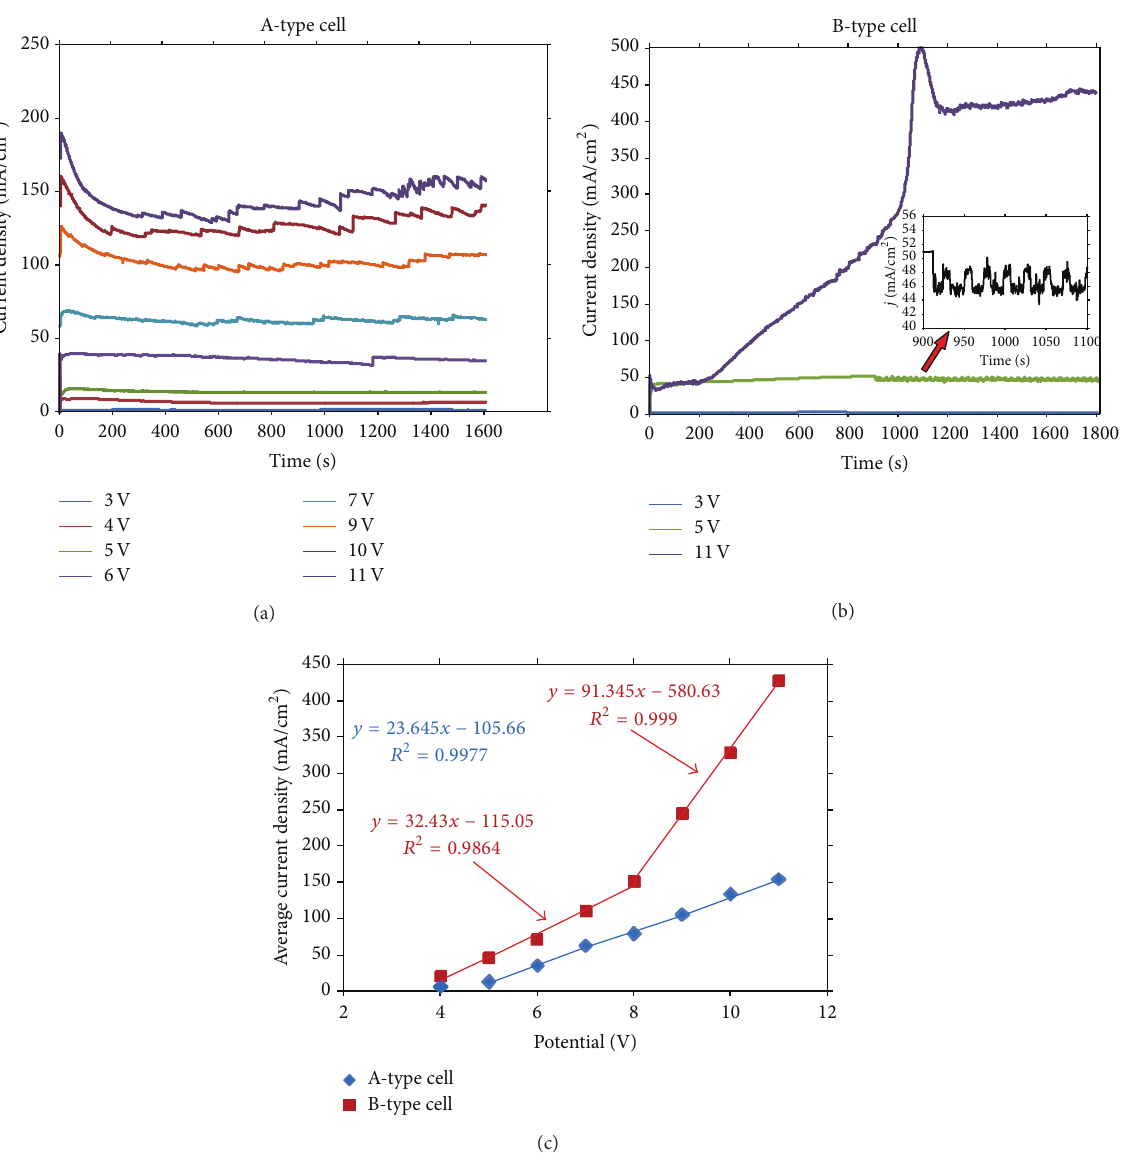
layered oxide structure with a lot of internal gaps and transversal pores can be recognized in Figure